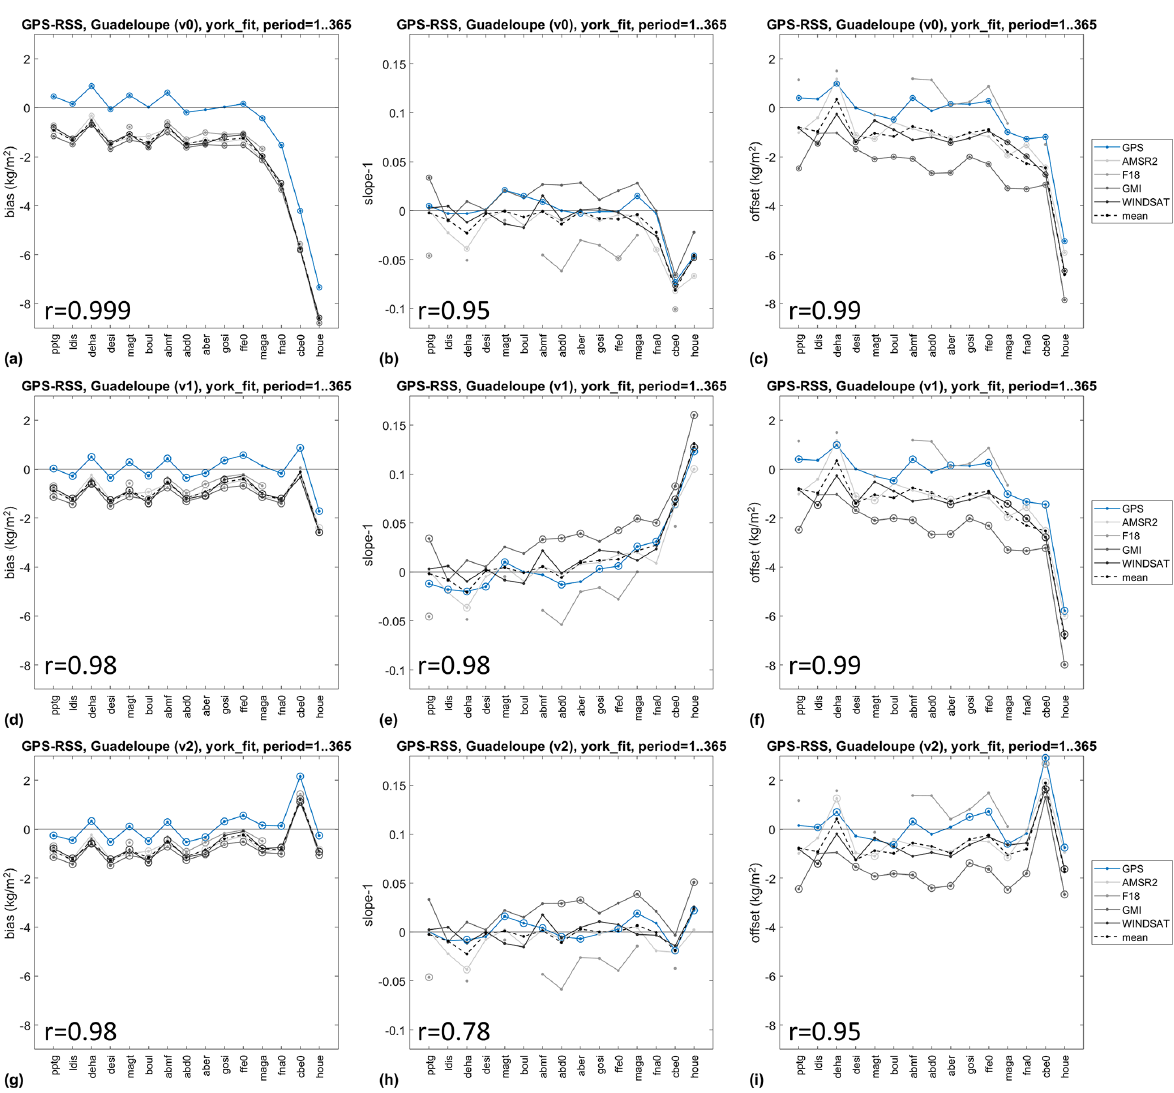
Figure 10. Bias, slope, and offset results for GPS–GPS comparisons (the blue line shows median of all GPS comparisons from Fig. 9 except for the full year) and for GPS–MWR comparisons from four different satellites (AMSR2, F18, GMI, and WINDSAT; the dashed black line shows the mean of all satellite results) for the year 2020. Slope and offset are estimated with the York et al. (2004) method. Bias and offset values significantly different from 0 and slope values significantly different from 1 are marked with a circle ( p value ≤ 0 . 01). Pearson correlation coefficients between GPS–GPS and mean GPS–MWR results are indicated in the lower left of each